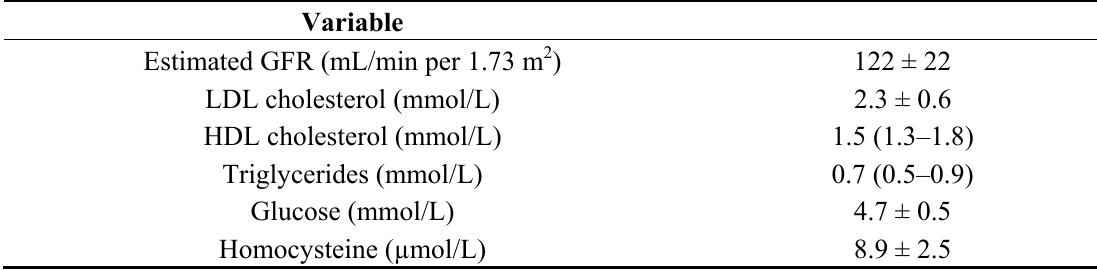
Table 1. Biochemical characteristics of the study subjects